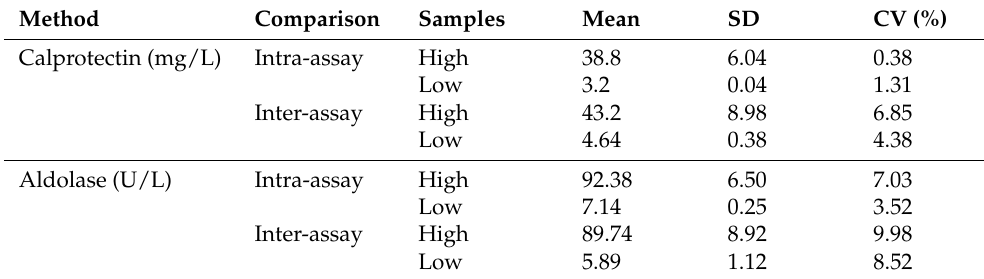
Table 1. Precision of the calprotectin and aldolase assays in horse saliva.